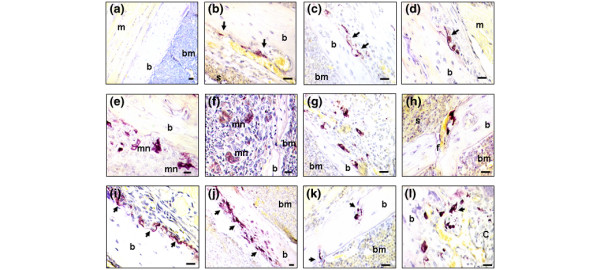
Increased tartrate-resistant acid phosphatase (TRAP)-positive staining following treatment with oncostatin M (OSM) with either IL-1 or tumour necrosis factor alpha (TNF-α) in murine joints. Mice were injected intra-articularly with adenoviral vectors as described in Fig. 1, and the animals were sacrificed at day 7 following administration. (a) No significant TRAP-positive cells outside the bone marrow were seen in control joints. Some TRAP-positive staining cells were located at the synovium-bone interface in (b) OSM-treated joints, (c) IL-1-treated joints and (d) TNF-α-treated joints. In both the (e)–(h) OSM + IL-1 and (i)–(l) OSM + TNF-α combinations, significant TRAP-positive staining was located at the front of the synovium–bone and the pannus–subchondral bone junctions, which were interposed between the bone surface and the 'erosive front' of the synovium (e, i and j). At many sites of focal bone erosions (arrows), TRAP-positive multinucleated cells were seen at the erosion front within the synovium (e, h–j), and within erosion pits in the bone (h and k). Furthermore, TRAP-positive staining cells were also seen at the cartilage/bone junction (l). b, bone; bm, bone marrow; c, cartilage; f, fracture; m, muscle; mn, multinucleated cells; s, synovial cells. (a)–(d), (g)–(l) Bar = 50 μm; (e), (f) bar = 20 μm.